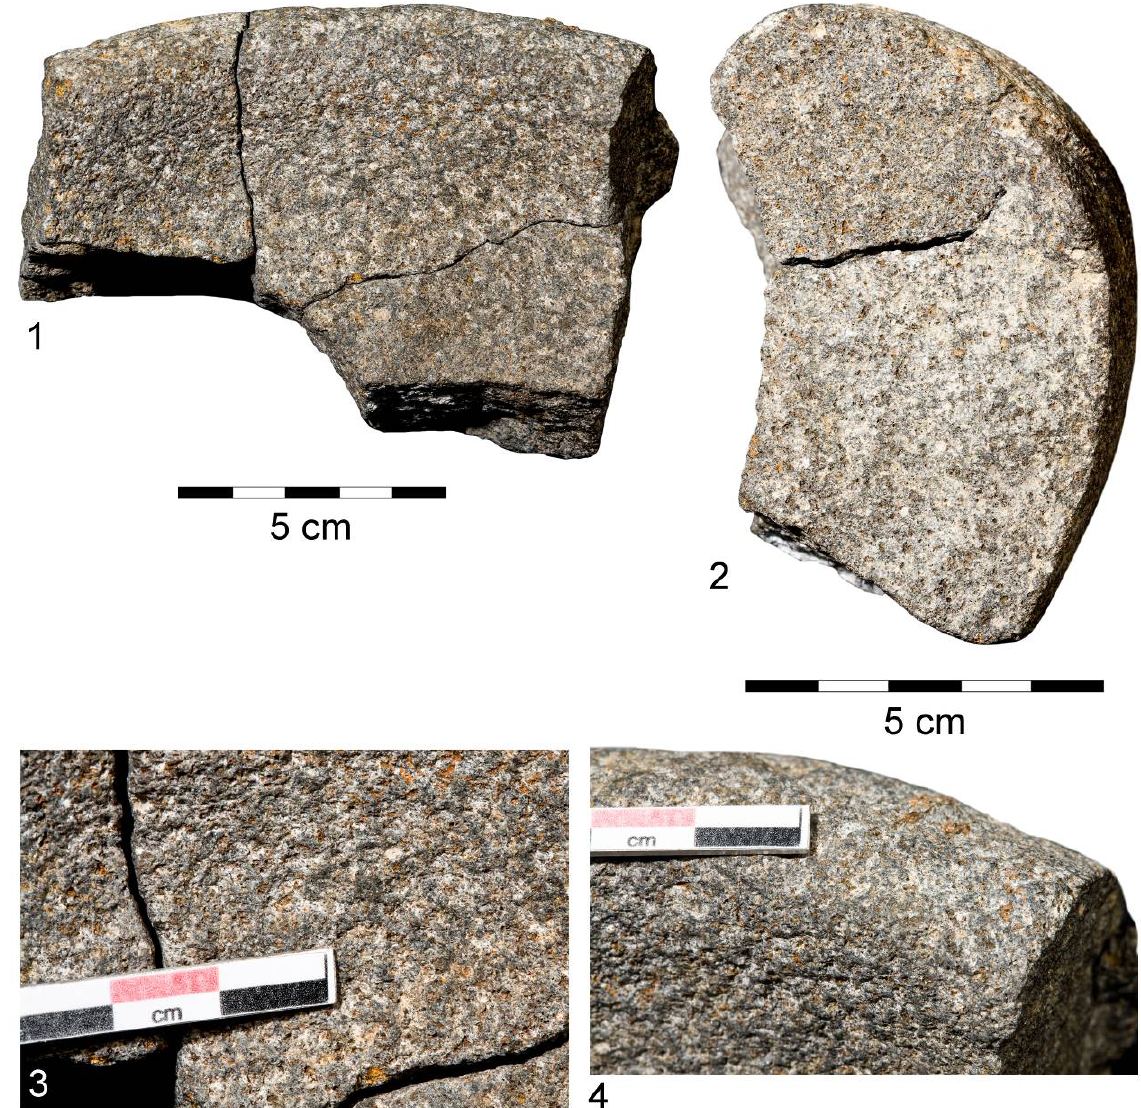
Figure 6 . Three refitted fragments of a basalt bowl, Loc. 12. 1) top view; 2) the smooth regular profile; 3) close- up view of the base; 4) close-up view of the